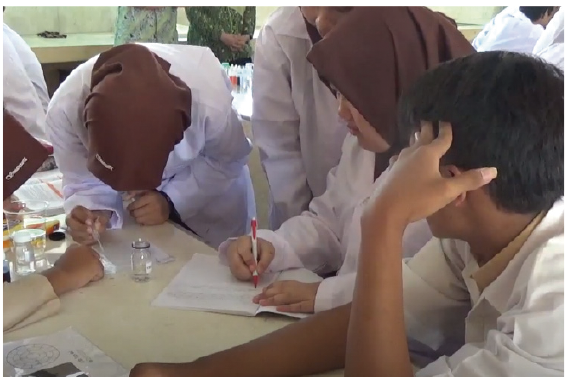
Figure 8. The seriousness of students and their groups to count the number of droplets and observe color